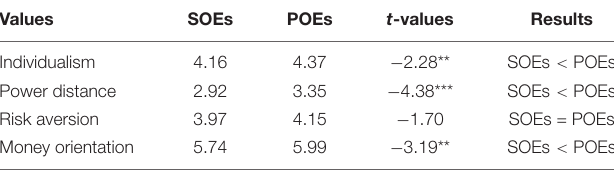
TABLE 2 | Values differences across types of